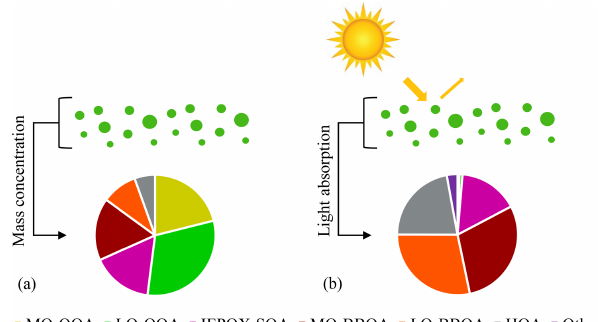
Figure 15. Comparative relationship of the relative contributions of PMF factor loadings to (a) organic PM 1 mass concentration and (b) organic PM 1 light absorption. Results represent means for the full data sets of IOP2. The means and standard deviations are listed in Table 4. Results are for 370nm. “Other” refers to the model inter- cept B (Eq.